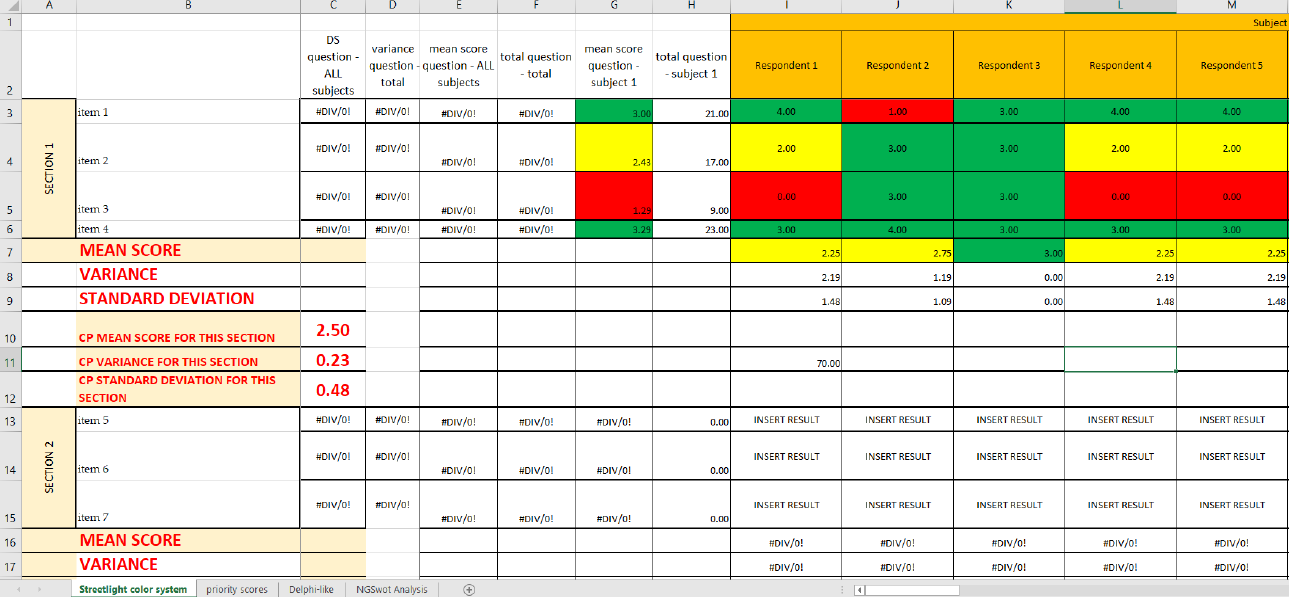
Figure 3. Example of SPRIS application. Photograph of the complete picture given by the Streetlight color system sheet, showing the first three Questionnaire Sections of the questionnaire for two CPs.